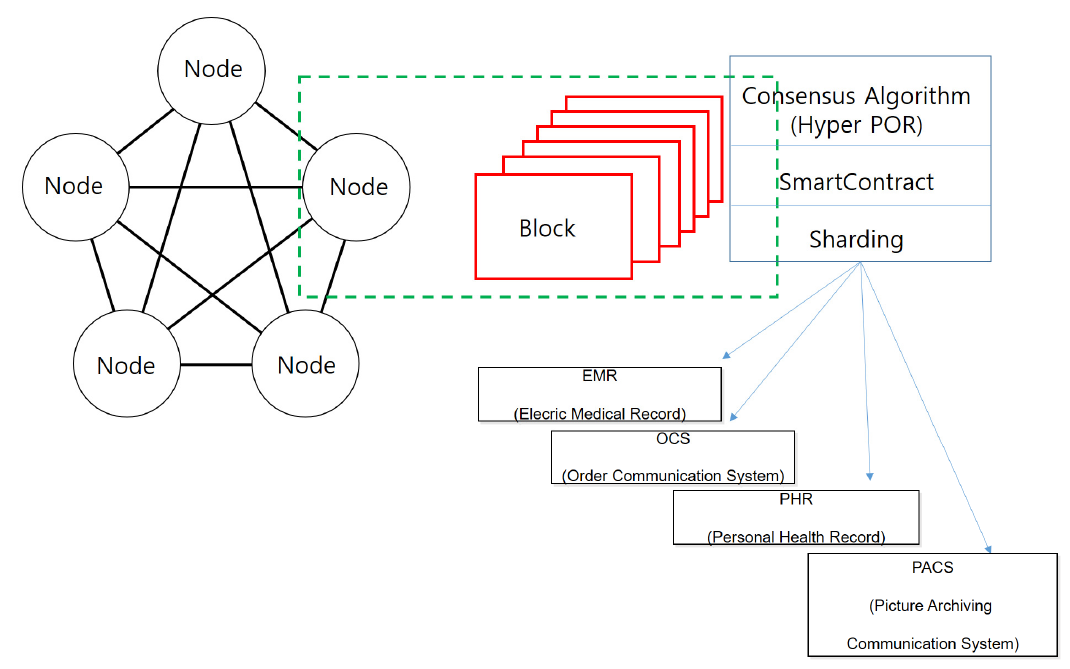
Figure 5. Blockchain algorithm for healthcare.